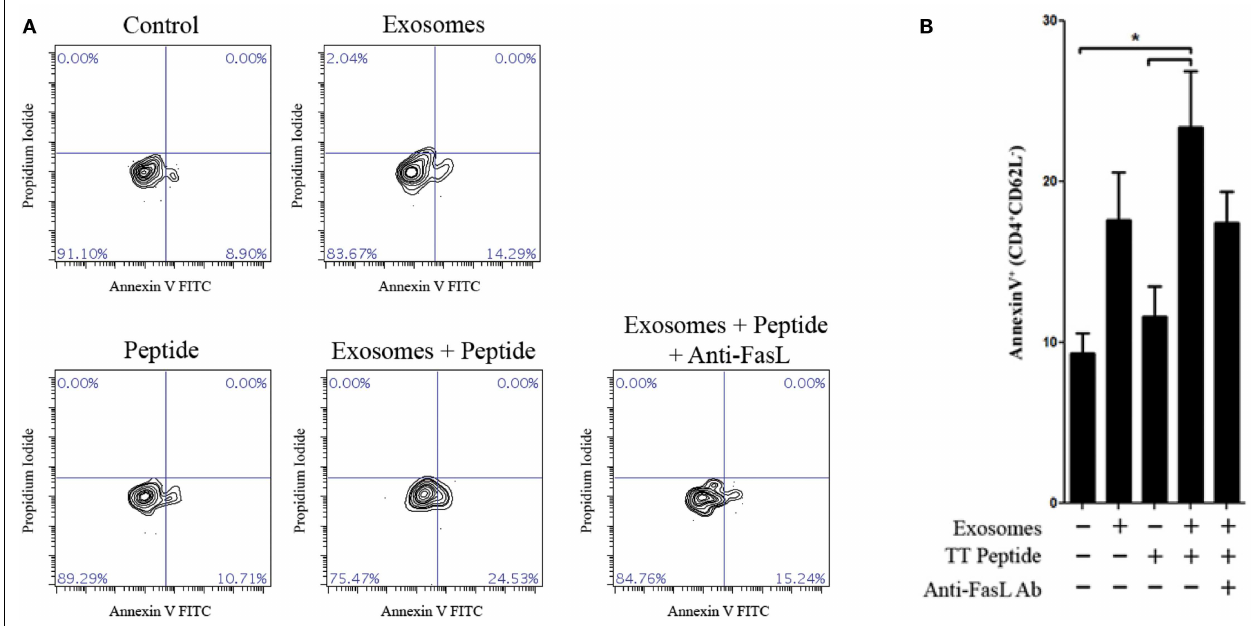
FIGURE 5 |Antigen-specific killing withTT peptide. Peripheral blood mononuclear cells were harvested from a repeat donor from whom we had previously generated an LCL.This donor had received a scheduled vaccination against tetanus < 1month prior to the experiment shown. PBMCs were cultured in the presence of an immunodominant peptide of the tetanus toxoid for 12days. CD4 + T cells were then isolated by negative selection and cultured overnight with or without autologous LCL-derived exosomes (156 µ g/mL) and in the presence or absence of the tetanus toxoid peptide. Neutralizing anti-human FasL antibodies (10 µ g/mL) were added to